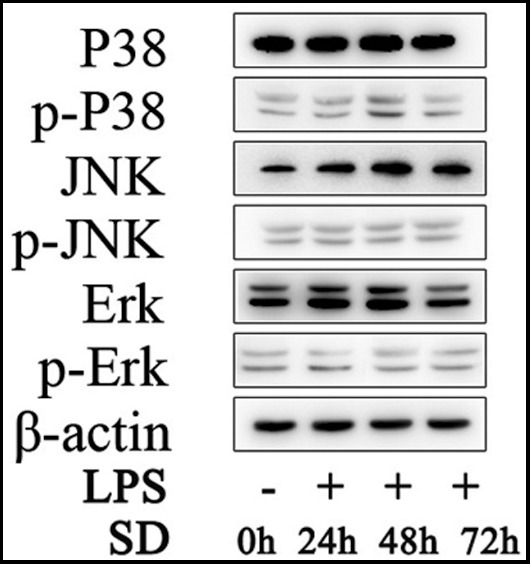
Protein bands of western blotting.